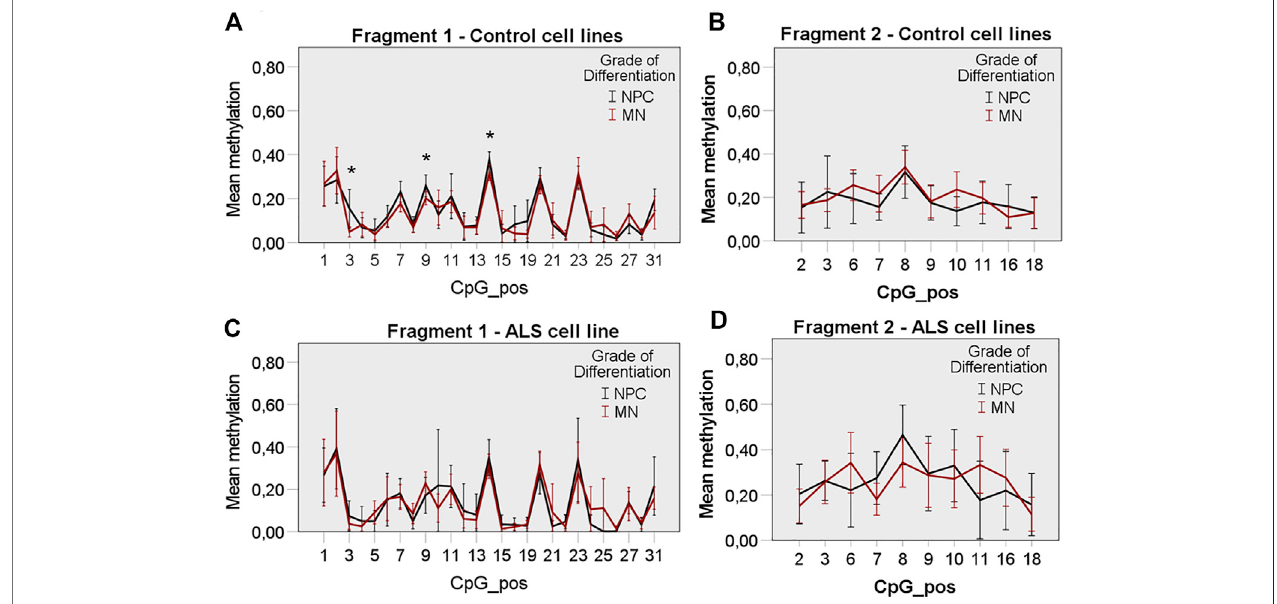
FIGURE5| CpG site-speci fi cmethylation ofthe FUS promoterduring MNdifferentiation. Controlcelllines display asigni fi cantmethylationchangeat CpGposition 3,9and 14duringdifferentiationinfragment1, (A) butnosigni fi cantmethylationchangeduringdifferentiationinfragment2, (B) .ALScelllines displaynosigni fi cantCpG site-speci fi c methylation change in fragment 1, (C) and fragment 2, (D) during differentiation. Statistical inferences were drawn from unpaired t -test and illustrated as mean ± SEM. Results were regarded as statistically signi fi cant with p < 0.05, n (cid:2) 3 per condition and n (cid:2) 3 per cell line.